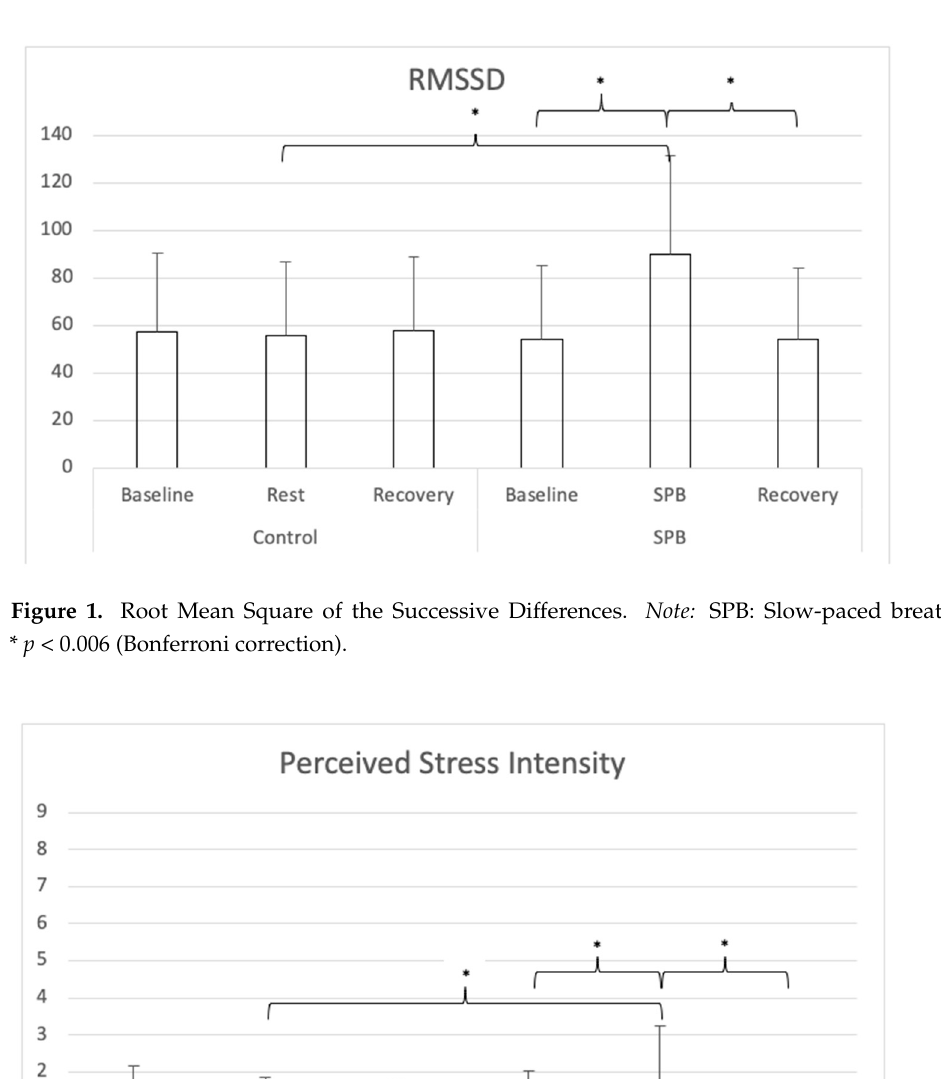
Figure 1. Root Mean Square of the Successive Differences. Note: SPB: Slow-paced breathing; * p < 0.006 (Bonferroni correction).